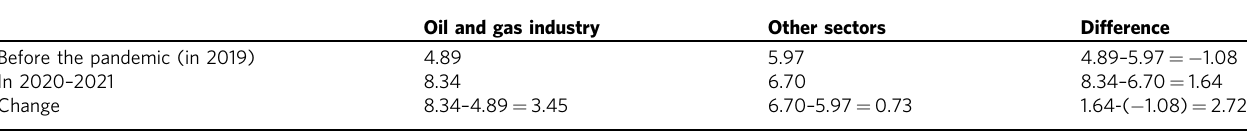
Table 3 The impact of tax incentives on the readiness of oil and gas companies to change in Russia using the Difference in Difference (DiD) method.